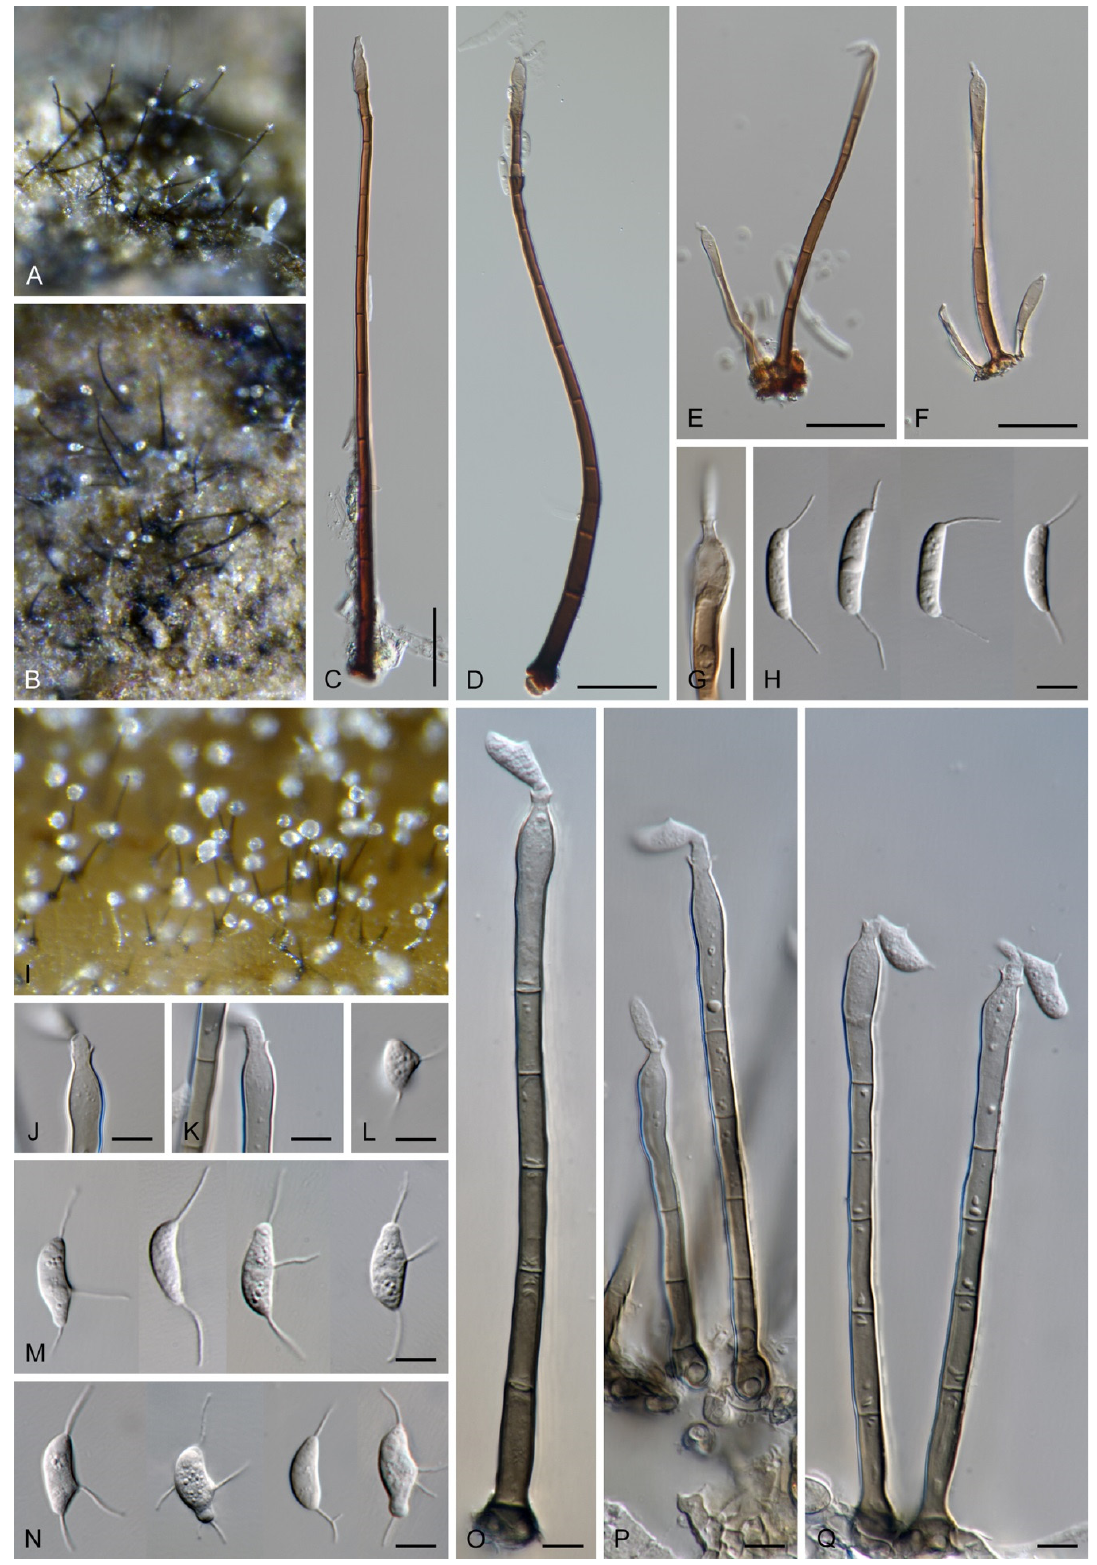
Figure 19. Codinaea phasma (CBS 147516 ex-type). ( A , B , I ) Colonies ( C , D ) setae ( E , F ) setae with conidiophores ( G ) conidiogenous cell ( H , M , N ) conidia ( J , K ) apices of the conidiogenous cells, conidiogenous locus slightly protruding above the collarette ( L ) conidium, from the top view ( O – Q ) conidiophores. Images: ( A – H ) from nature ( I – Q ) on stems of U. dioica on CMA after 4 weeks. Scale bars: ( C – F ) 25 μ m; ( G , H , J – Q ) 5 μ m.